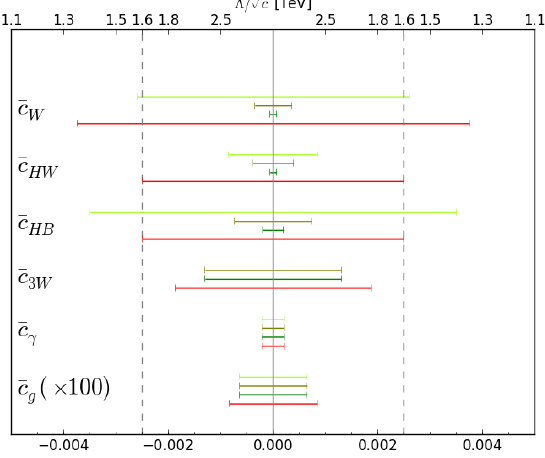
Figure 4 . As for (cid:12)gure 3, but for CLIC measurements at 3